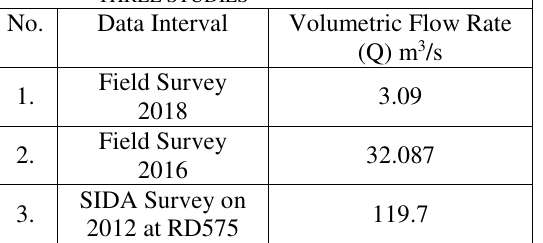
TABLE 3: CALCULATED FLOW RATES FROM THE THREE STUDIES No. Data Interval